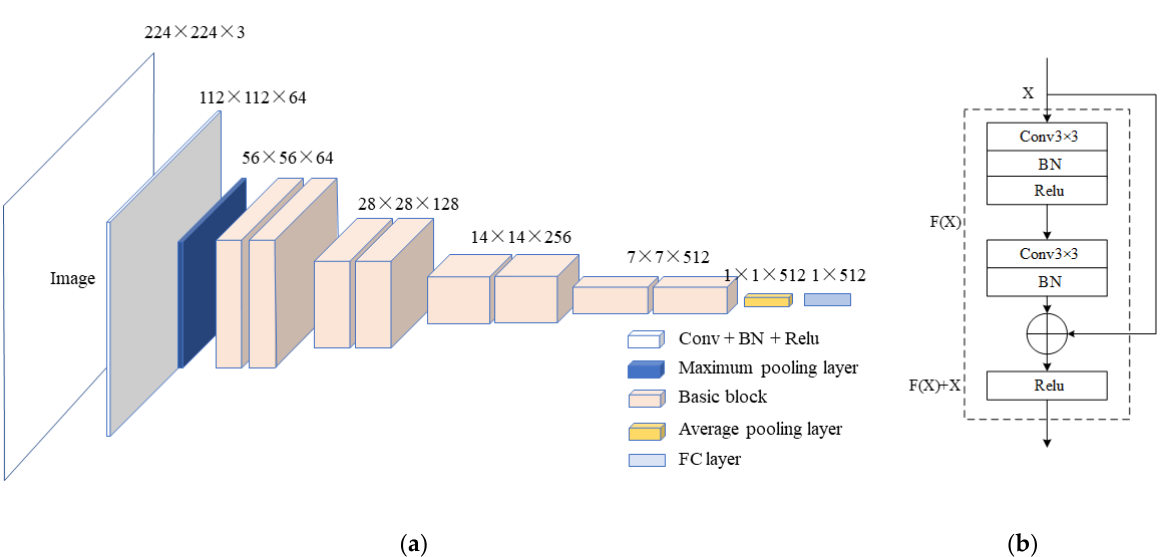
Figure 3. Resnet network. ( a ) It consists of 18 network layers, including the convolution layer, the maximum pooling layer, four basic blocks, the average pooling layer and the full connection layer. ( b ) A basic block consists of two convolution layers, two BN layers and two Relu layers [27].